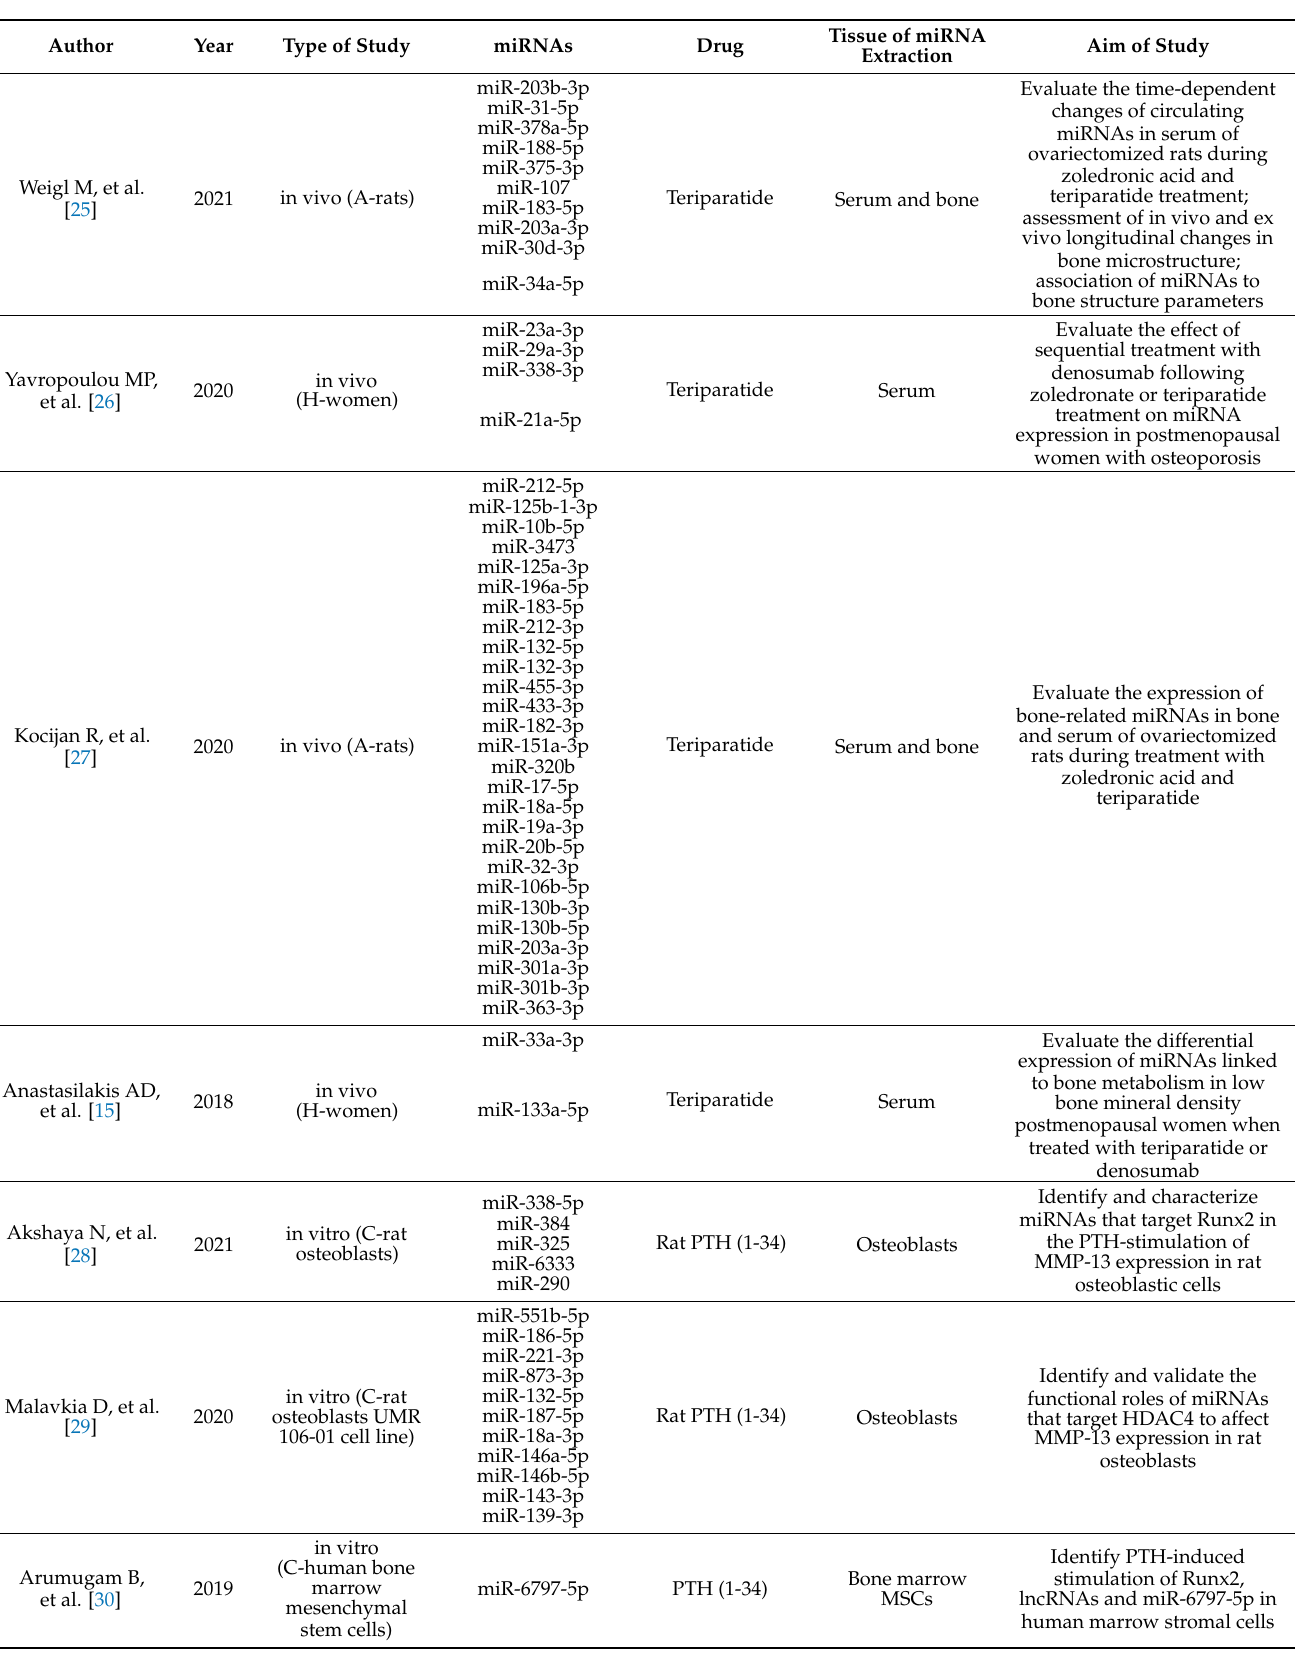
Table 1. The final set and characteristics of included studies obtained by a detailed literature